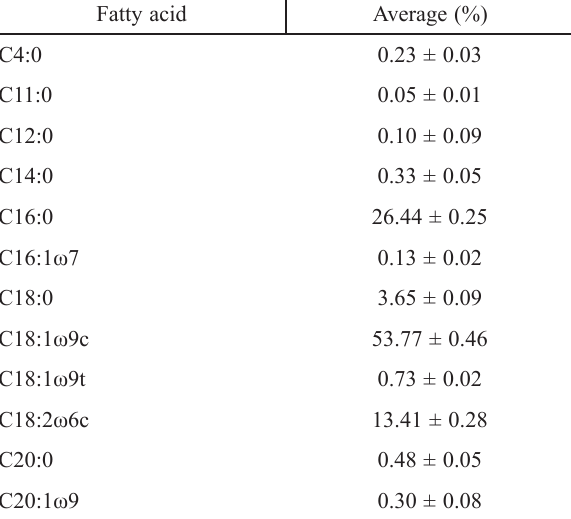
Table 1 – Fatty acid profile of the crude palm oil (Elaeis guineensis) used in the submerged cultivation of B. cepacia and